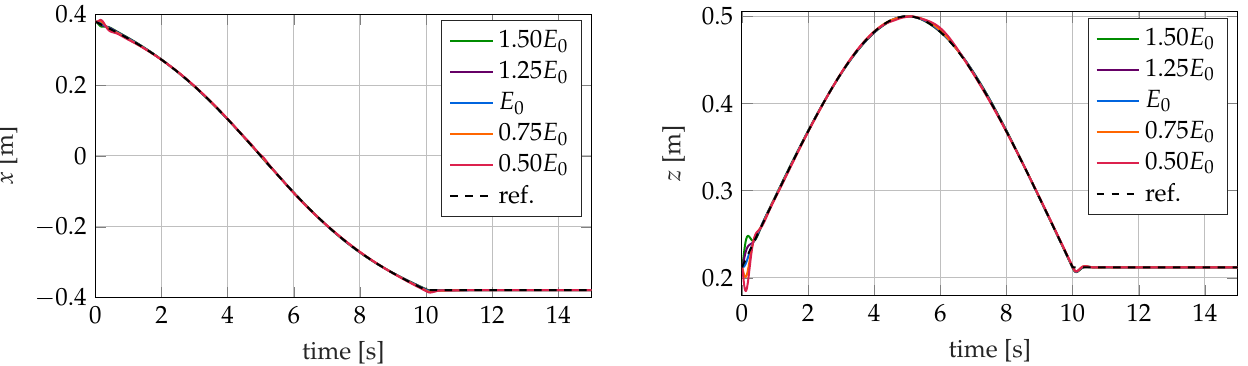
Figure 16. Trajectories of the tip position for the kinematic controller for different values of the young’s modulus E .